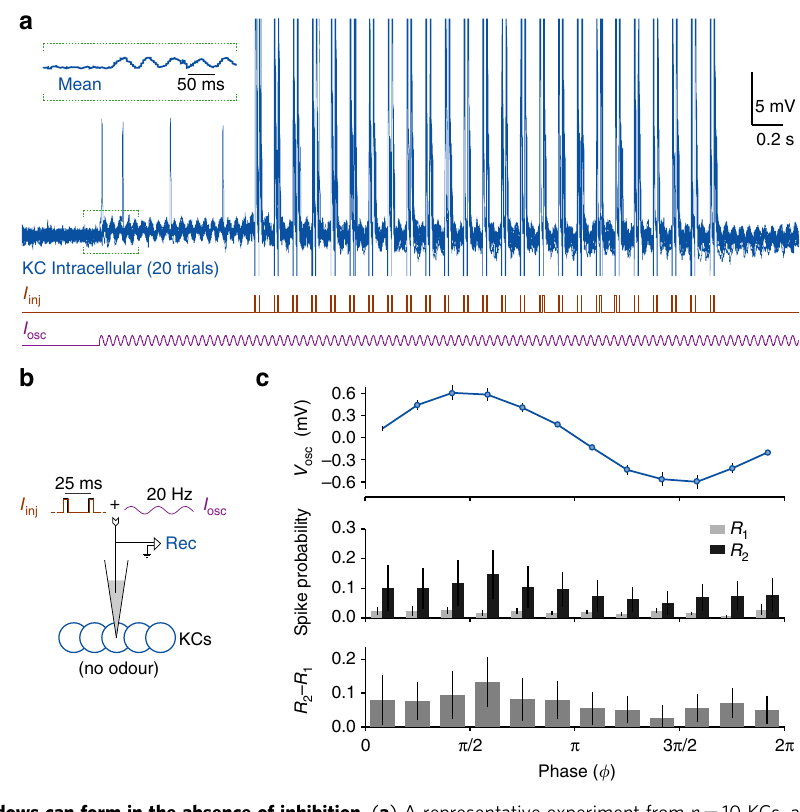
Figure 4 | Integration windows can form in the absence of inhibition. ( a ) A representative experiment from n ¼ 10 KCs, and ( b ) the experiment design are shown. Purely excitatory oscillatory waveforms ( I osc ), and 25 pairs of 5-ms pulses ( I inj ), were injected directly into the KC through the intracellular electrode, without eliciting network inhibition. Membrane potential oscillations were induced by I osc . Inset: the mean membrane potential (20 trials) of the indicated segment. ( c ) Current injections evoked robust oscillations in the subthreshold membrane potential of the KC. Lacking inhibition, KCs still formed integration windows: R 2 (cid:2) R 1 showed the same phase-dependence as seen previously with odour stimulation (see Fig. 2). Error bars represent